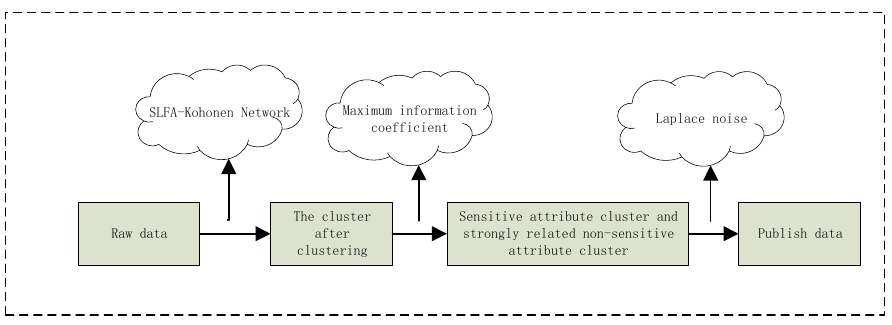
Figure 3. SSKM_DP data publishing framework satisfying differential privacy protection.